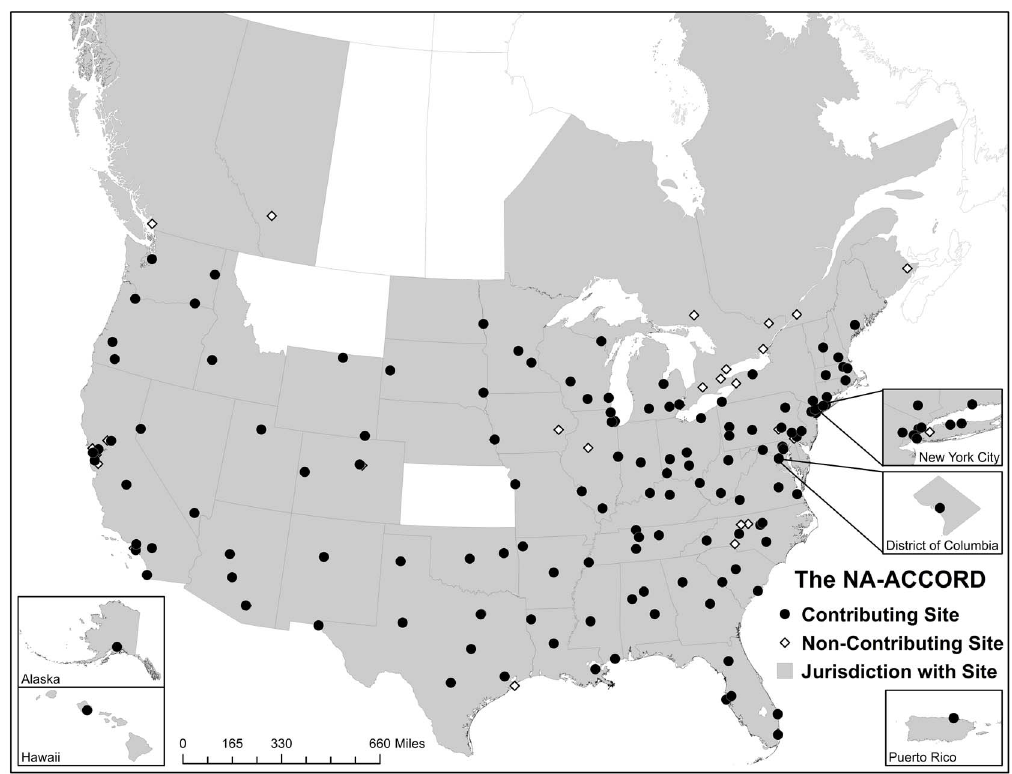
Figure 1. Geographic distribution of North American AIDS Cohort Collaboration on Research and Design (NA-ACCORD) clinical sites contributing to these analyses. Non-contributing sites were interval cohorts, Canadian cohorts (excluded due to the focus on US clinical care populations), or cohorts not currently contributing HIV primary care encounter data to the NA-ACCORD.